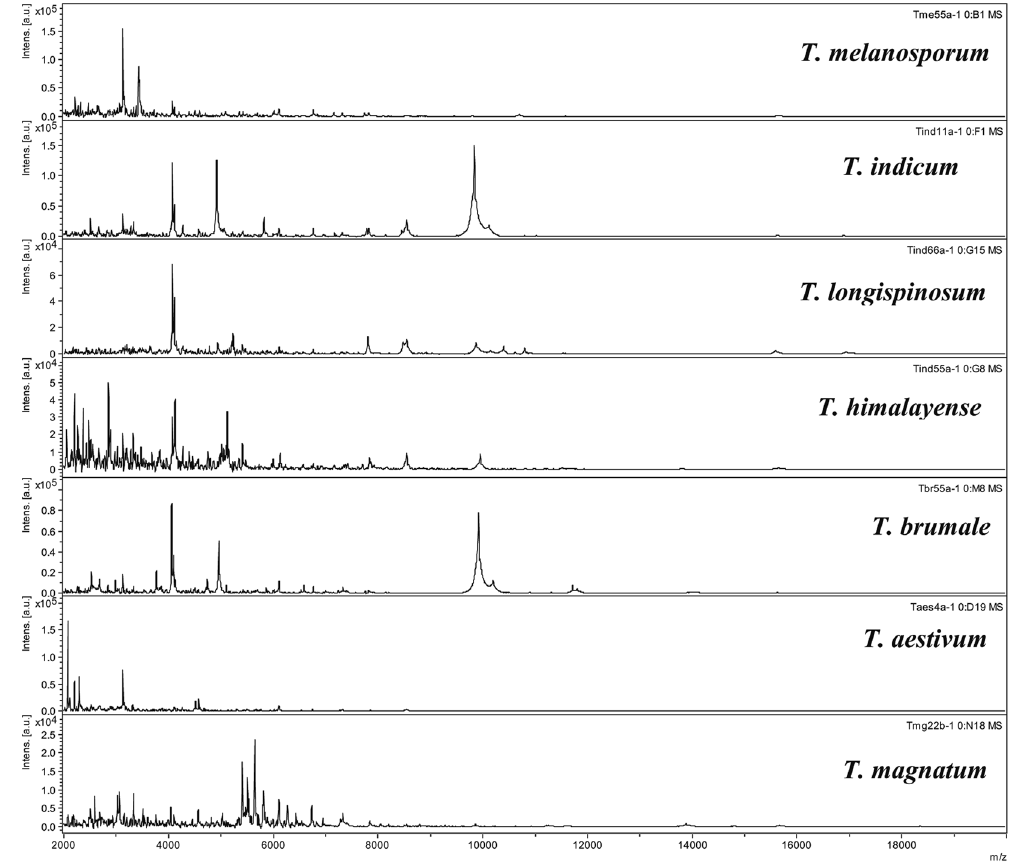
Figure 2. MALDI-TOF mass spectral profiles of the seven Tuber species identified in this study. Intens. [a.u.]: Intensity [arbitrary